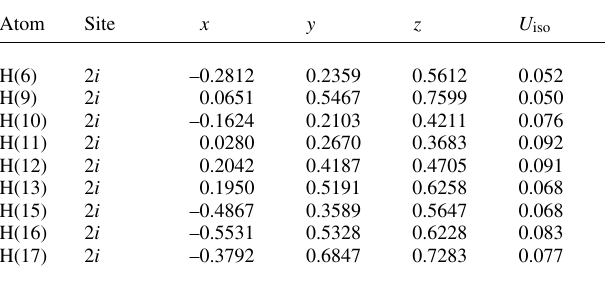
Table 2. Atomic coordinates and displacement parameters (in Å 2 )